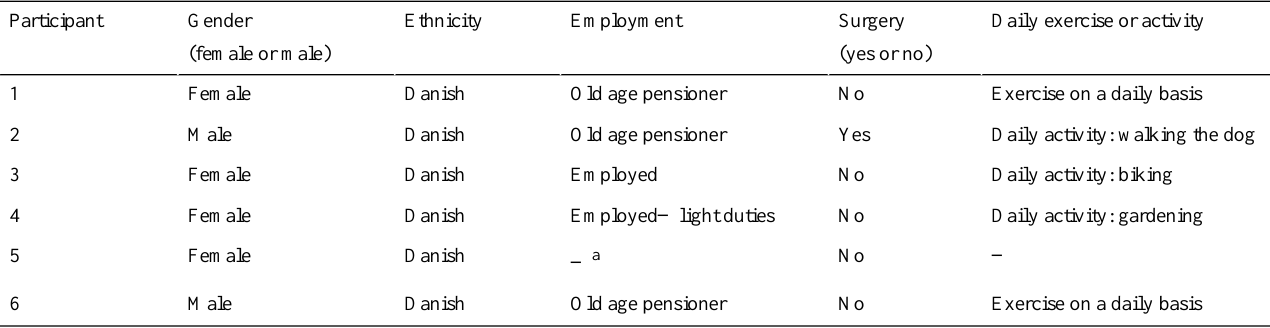
Table 1. Characteristics of the